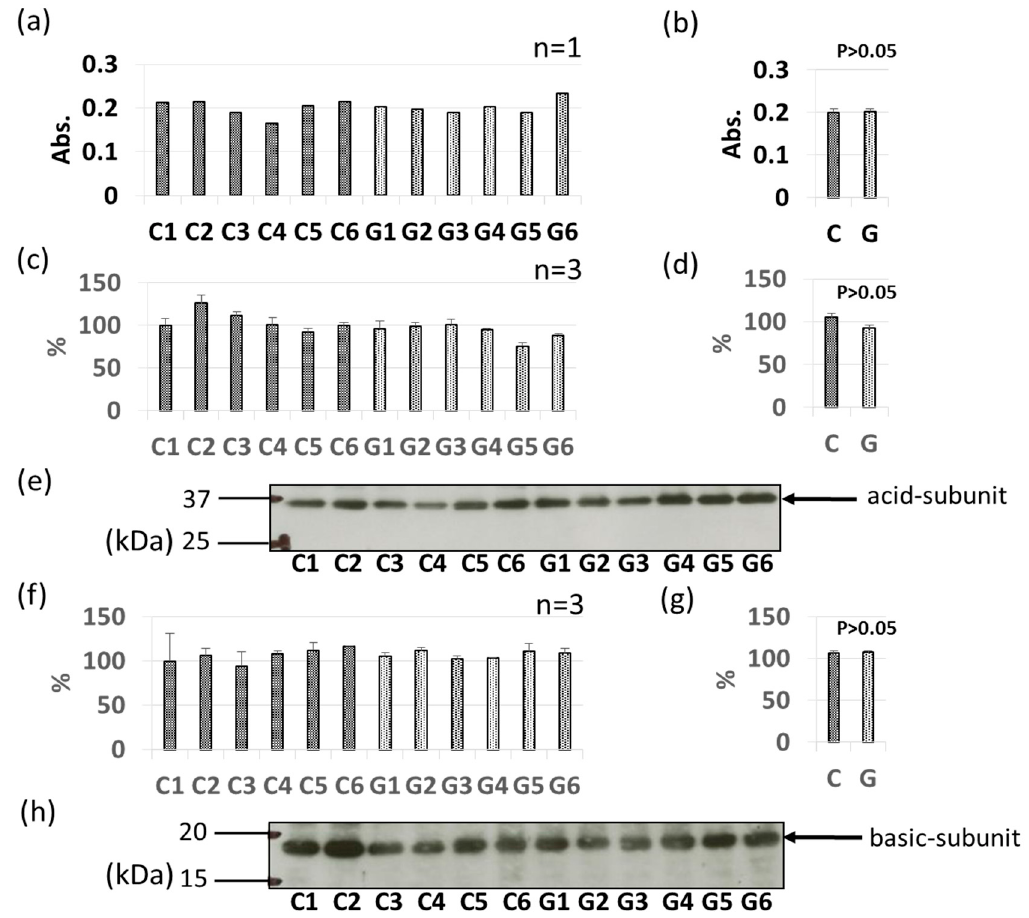
Figure 8 . Comparison of Gly m 6 levels in GM-and non-GM soybeans by ELISA ( a,b ) and immunoblotting (c–h) using mouse-derived polyclonal antibodies. Soybean protein extracts were evaluated by ELISA (a,b) and immunoblotting (c–h) for detection of Gly m 6 levels. The ELISA data are presented in absorbance values (Abs). The acidic subunit of Gly m 6 was detected (c–e) separately from the basic subunit of Gly m 6 (f–h) . The individual data from six GM-and non-GM soybeans (c,f) are presented as the mean ± SD of three independent replicates. The collated data (b,d,g) are presented as the mean ± SD of all individual data points from the control (C1–C6, six non-GM soybeans) or experimental (G1–G6, six GM soybeans) groups relative to the value of control number 1 (C1). Representative immunoblots are also provided (e,h) .